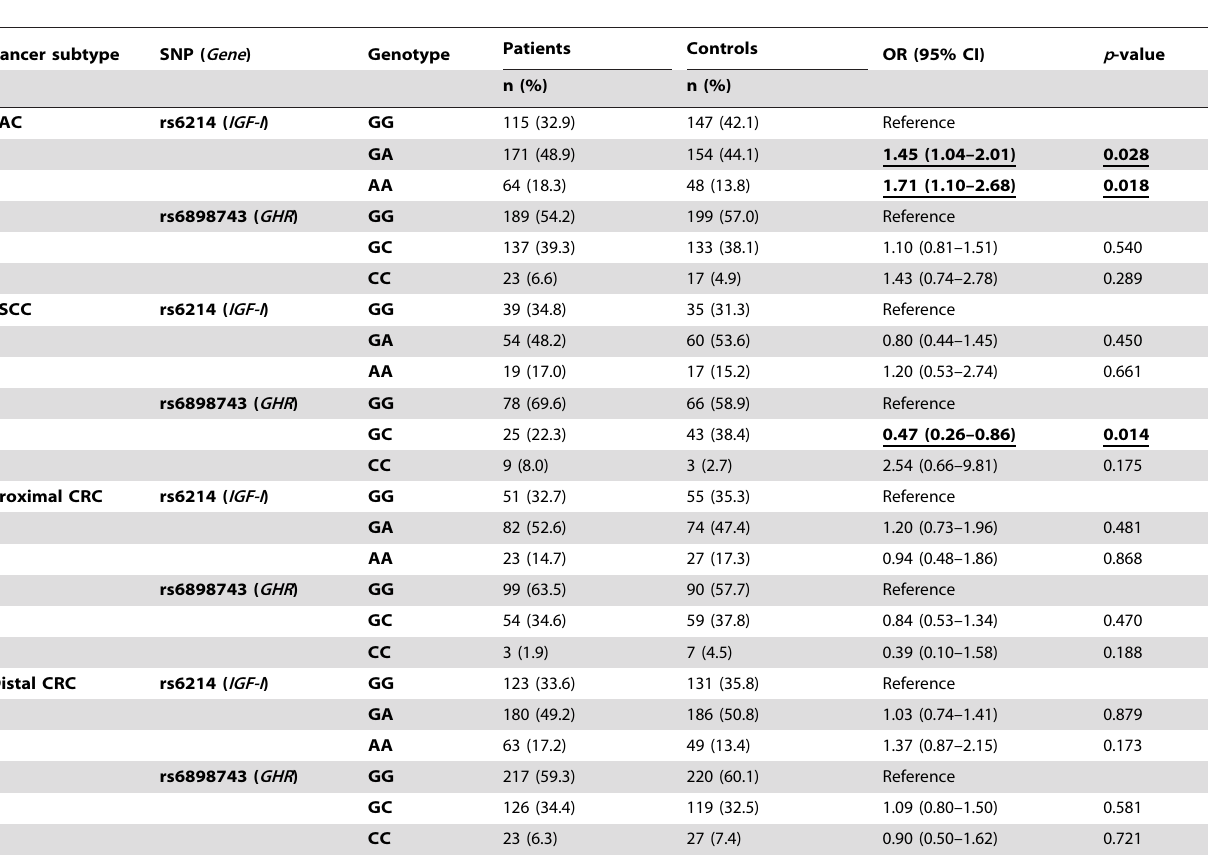
Table 5. Genotype distribution and ORs (95% CI) for the genotypes of SNPs rs6214 and rs6898743 in patients with EAC, ESCC, proximal CRC or distal